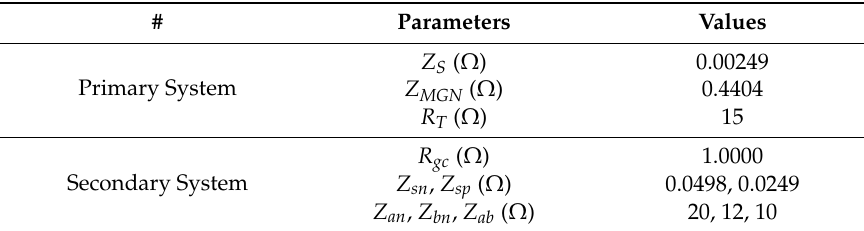
Table 1. Equivalent circuit parameters for the studied